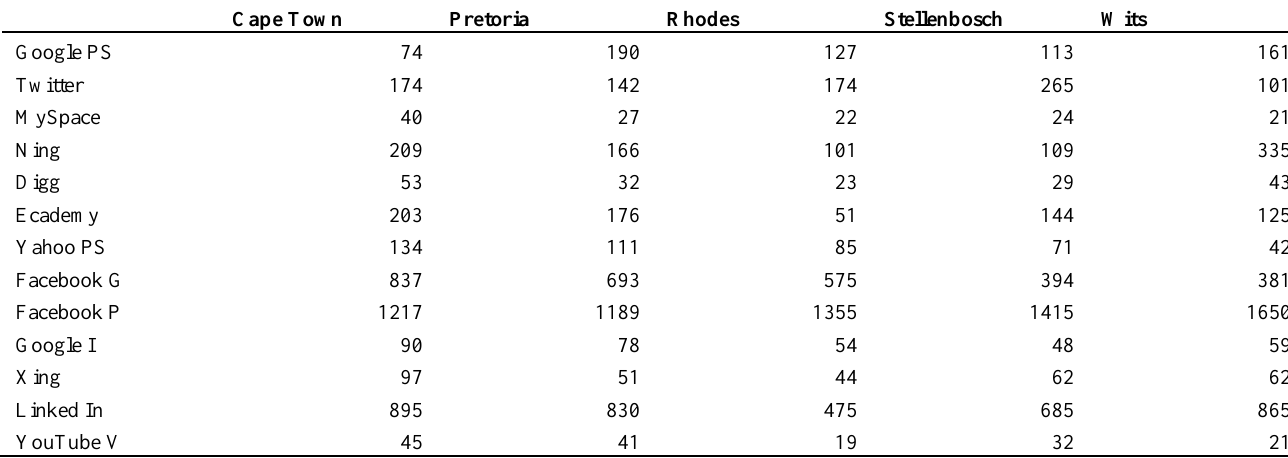
Table 1: Table of the University brands by visibility score in individual social media Cape